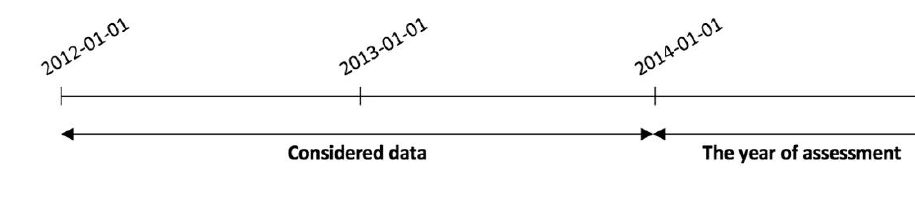
Figure 4. Dataset Segmentation.